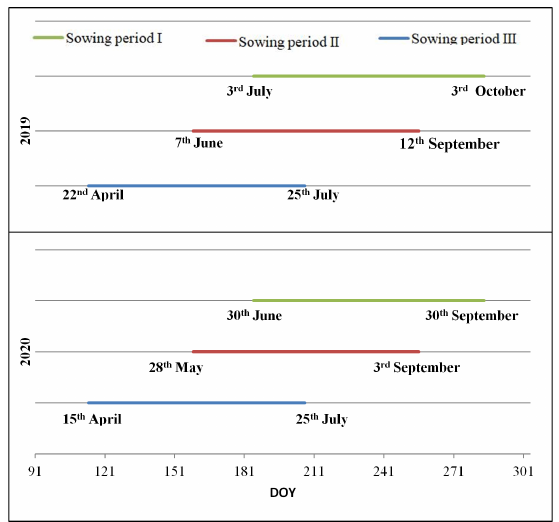
Figure 3. Growing season of common bean and sowing dates of the